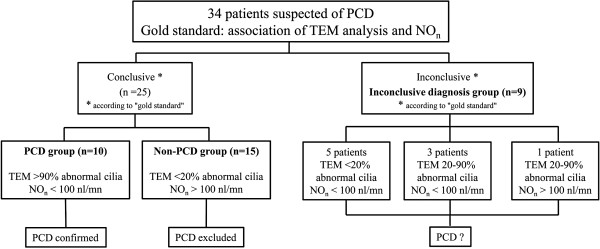
Determination of the patient groups according to the “gold standard”.